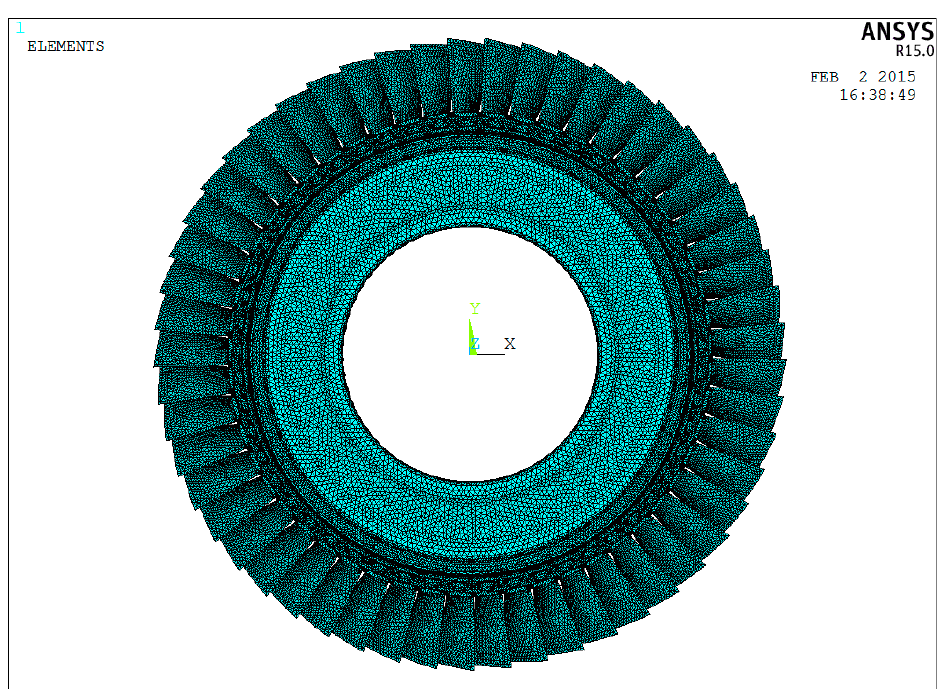
Figure 11. 3D solid model of the second-stage leaf disk.